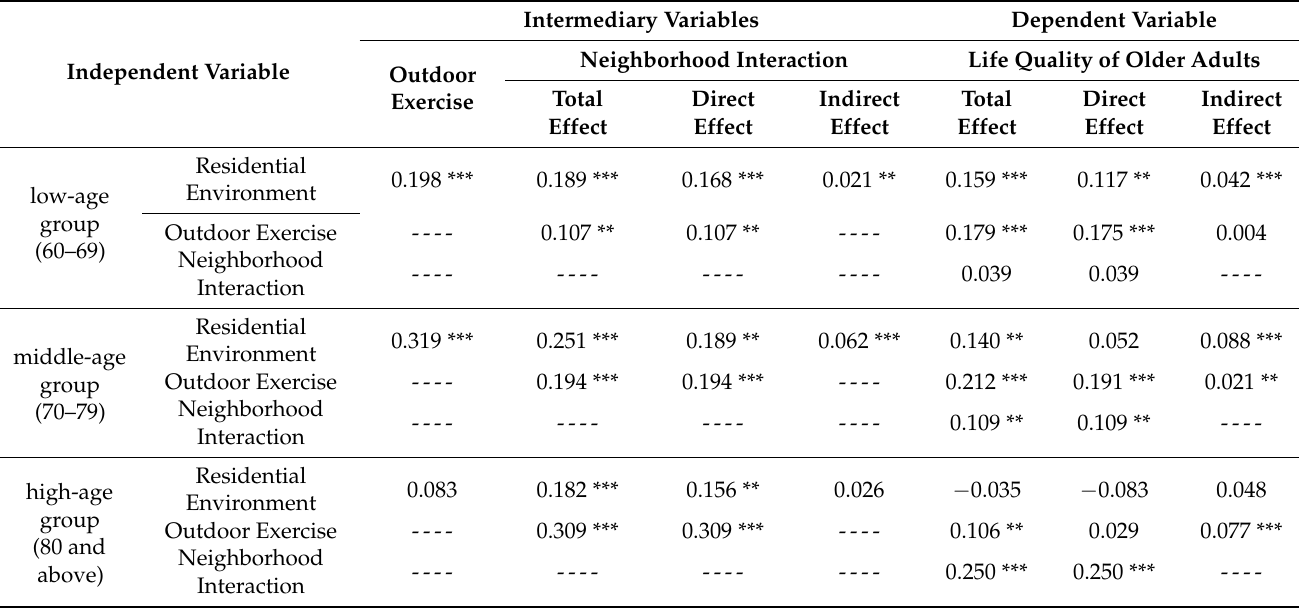
Table 4. comparison of the model paths in different age